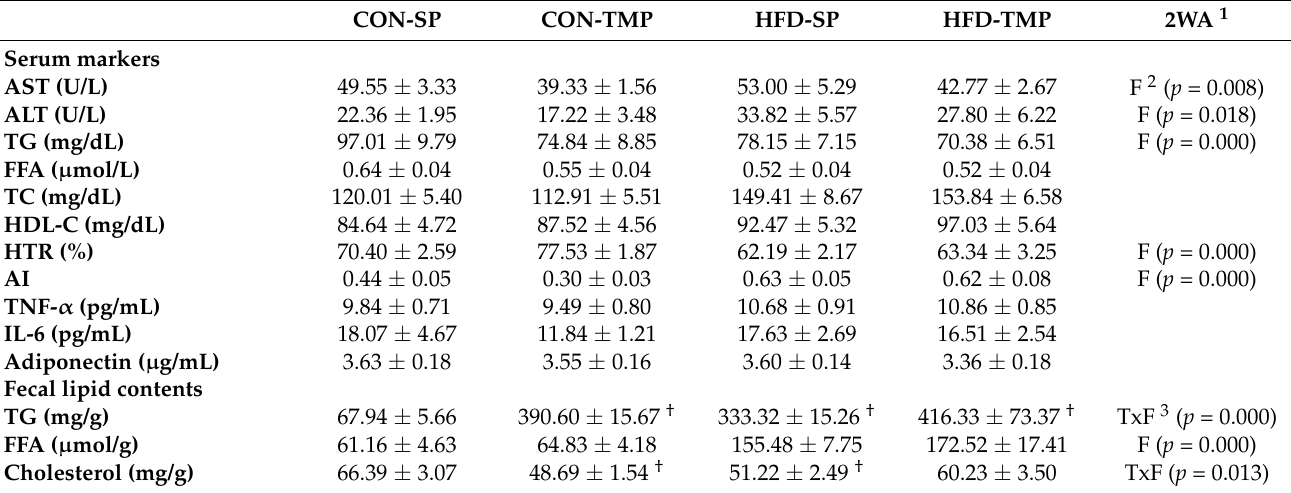
Table 3. Serum markers and fecal lipid